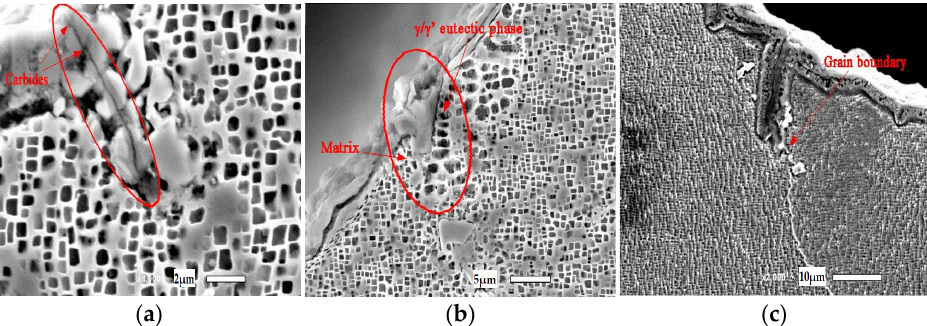
Figure 2. Crack initiation at different points: ( a ) at γ matrix phase and carbides, T max = 1000 °C, 10 cycles; ( b ) at interface of γ matrix and γ / γ′ eutectic phase, T max = 900 °C, 20 cycles; ( c ) on the grain boundary, T max = 1000 °C, 30 cycles. (Reprinted with permission from Reference [64], Copyright 2019,